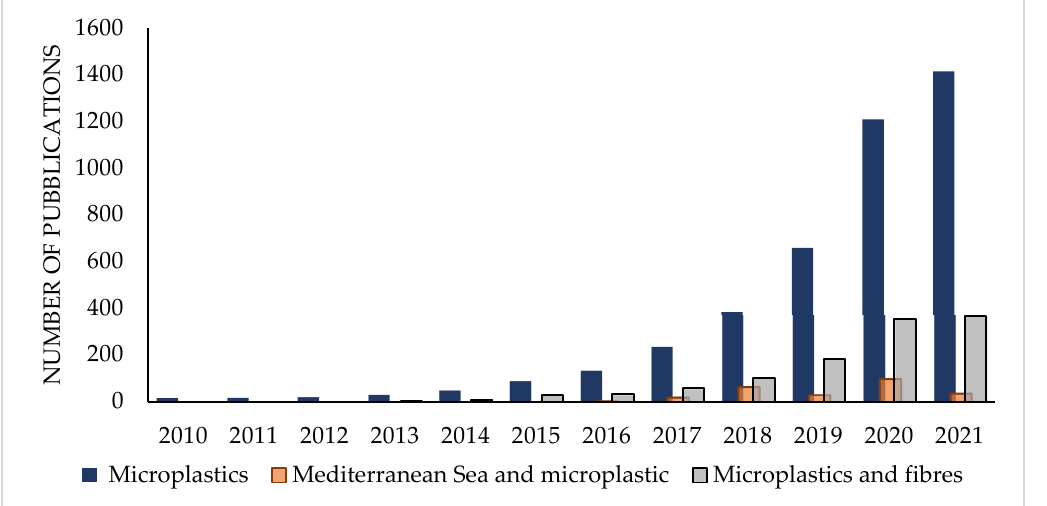
Figure 1. Number of publications per year studying MPs in the environment, MPs in the Mediterranean Sea and MPs/fibers. Source: Web of Science Database.